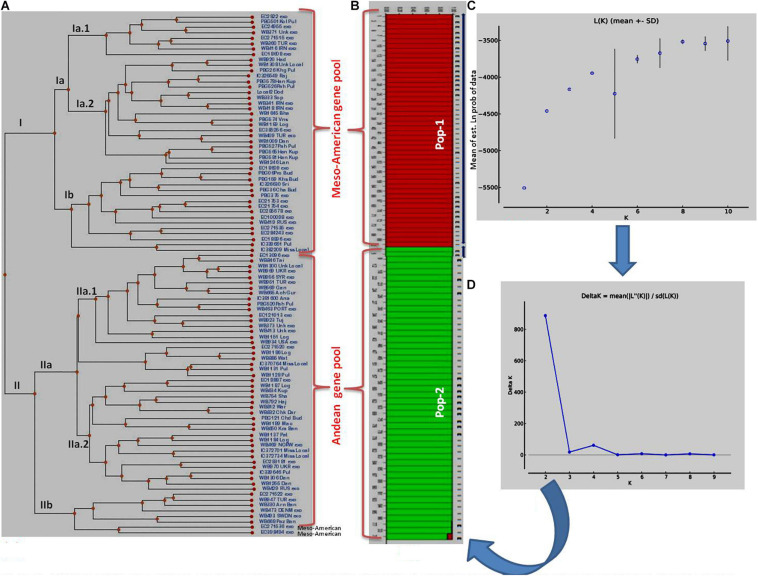
Clustering of 96 common bean genotypes: (A) Traditional UPGMA hierarchical clustering where 96 genotypes have been clustered into two groups (Mesoamerican vs. Andean types). (B) Bayesian clustering of 96 genotypes in the form of structure plots where two sub-populations could be easily distinguished from each other. The red plots show Mesoamerican sub-population, while green plots show Andean sub-populations. (C) Plot of Ln (K) values of different sub-populations from 1 to 10. (D) Rate of change of Ln (K) from sub-population 1 to 10 based on Delta-K method.